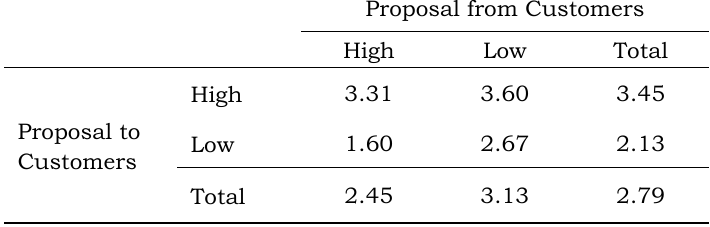
Table 5. Average sales of high DC group